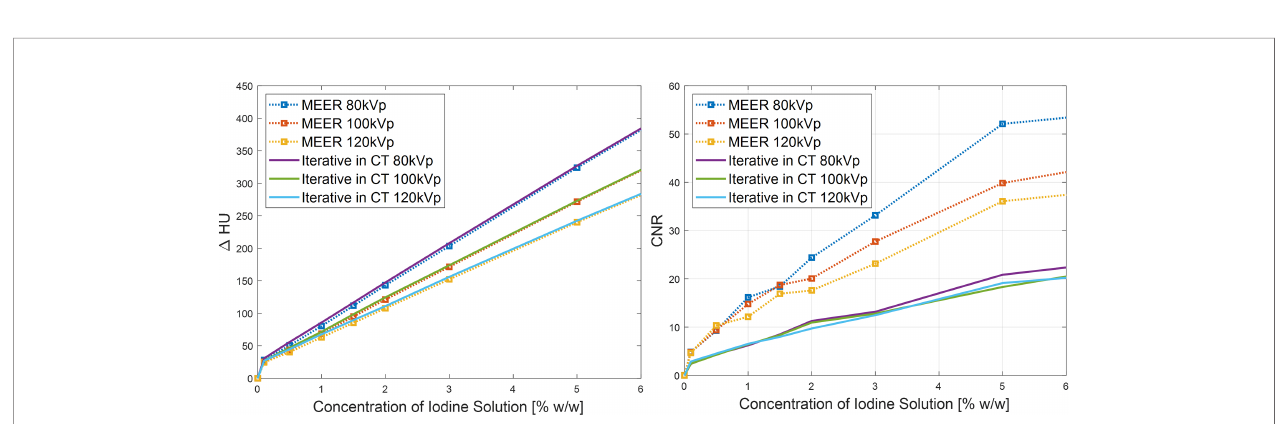
FIGURE 7 | Comparison of CNRs between our method and FBP reconstruction method in simulation study (left) and experimental study (right). Result of 10% iodine concentration not displayed to focus on relevant